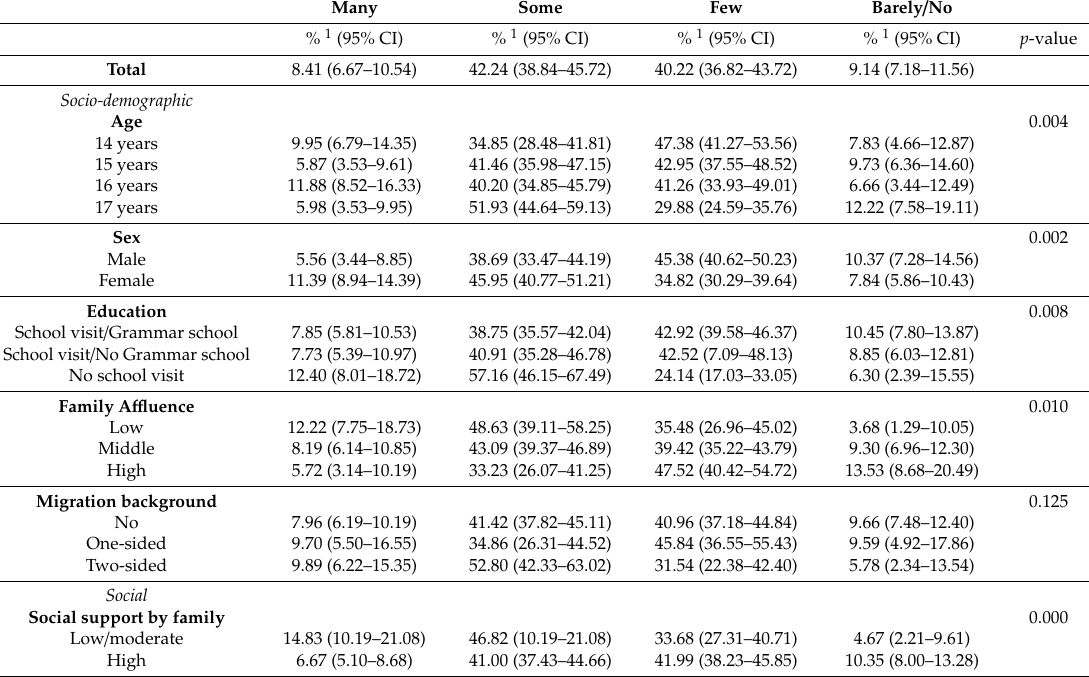
Table 3. Scale A: Weighted percentages and bivariate associations of reported di ffi culties in dealing with health-related information and considered factors among adolescents aged 14–17 ( n = 1202) based on GeKoJu 2019